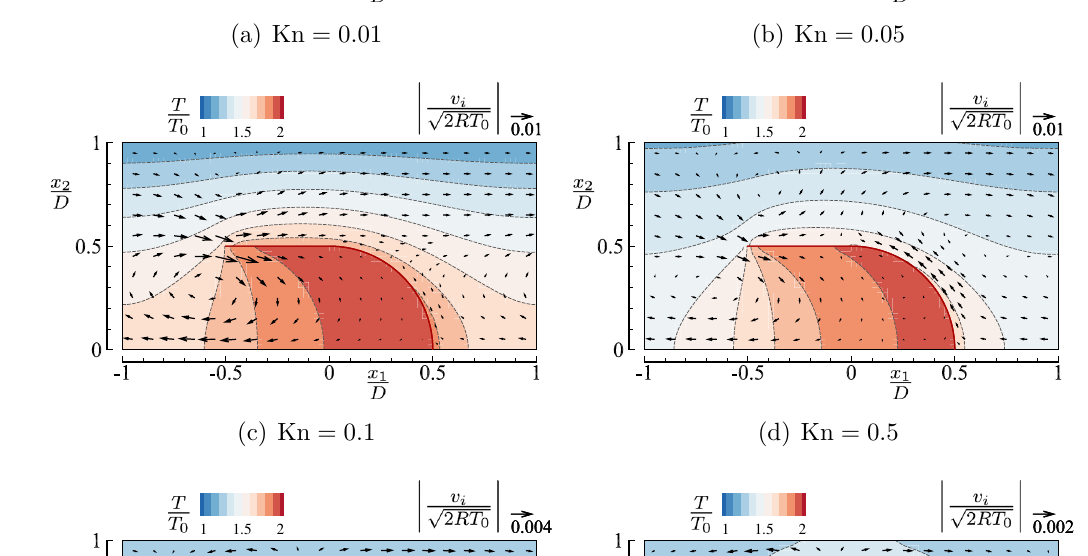
( a ) 0.01, ( b ) 0.05, ( c ) 0.1, ( d ) 0.5, ( e ) 1, =